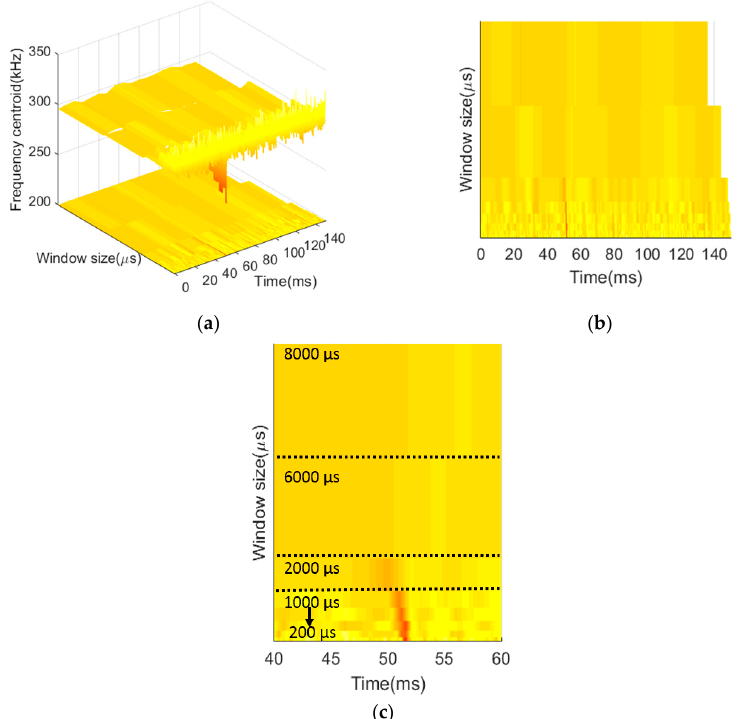
Figure 15. The spectra of frequency centroid by selection of different window size, ( a ) three-dimensional (3D) suface plot ( b ) projected to xy plane, and ( c ) window of ( b ) with the time window of 40 ms to 60 ms.